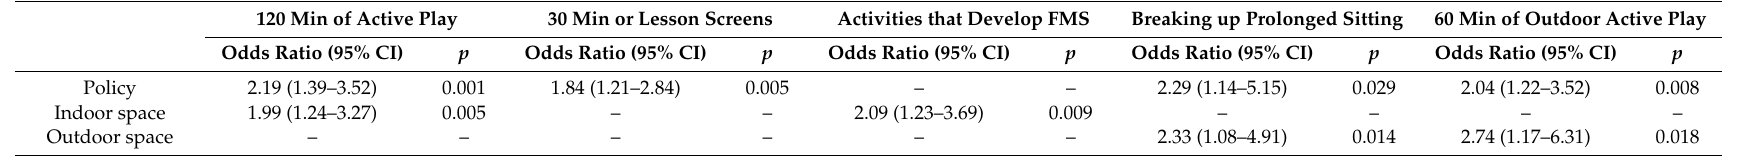
Table 4. Policy and environmental correlates of Active Play standards for the full sample of childcare facility managers.